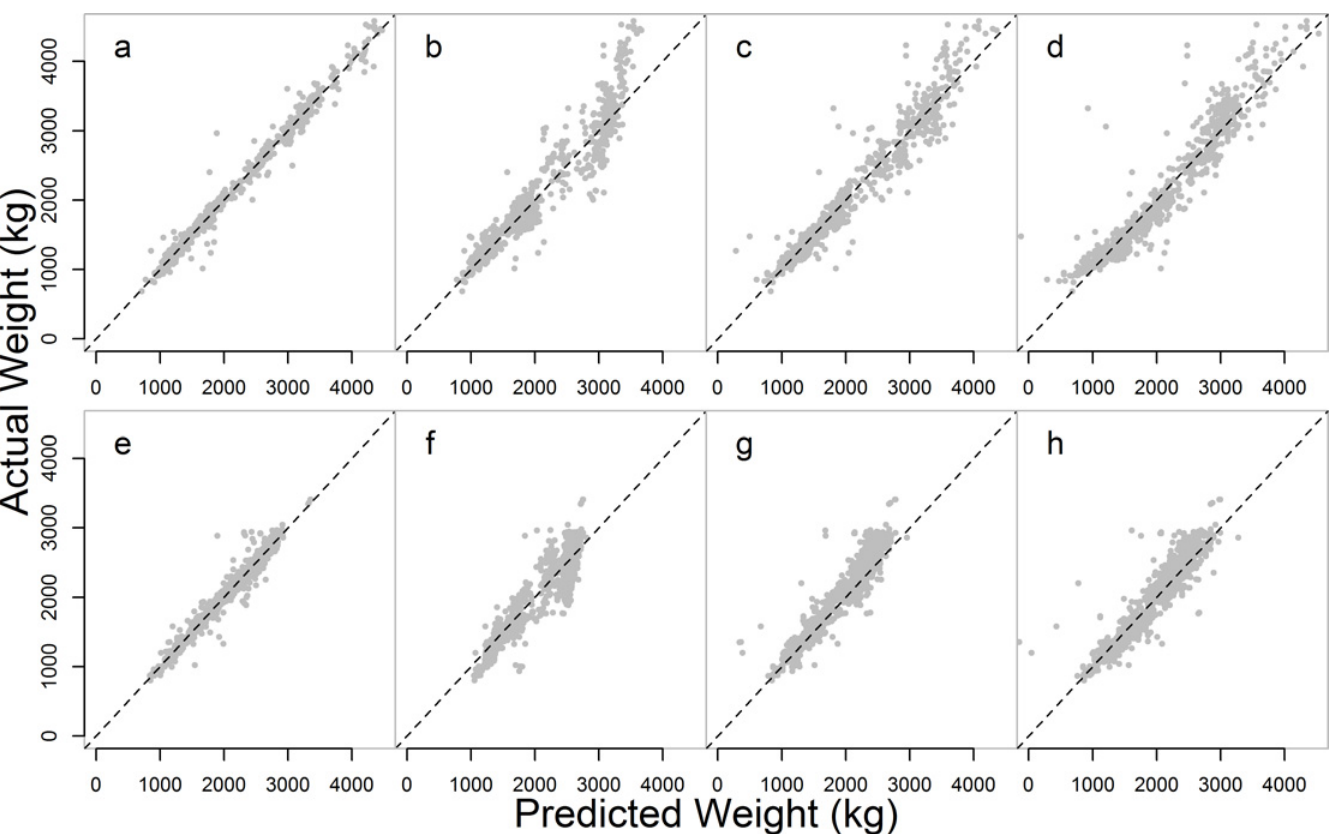
Fig 3. Comparison of fit of predicted values from different equations. a) male mixed-effects model; b) equation derived from mixed-effects model for males; c) equation derived from linear regression model for males (Eq 1); d) equation derived from linear regression model without age terms for males (Eq 2); e) female mixed-effects model; f) equation derived from mixed-effects model for females; g) equation derived from linear regression model for females (Eq 3); h) equation derived from linear regression model without age terms for females (Eq 4). The black line is 1:1 predicted weights to actual weights. Points above the line are underestimated, and those below are